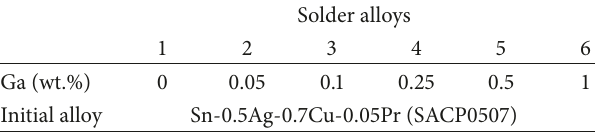
Table 1: Composition of solder alloy (wt.%).